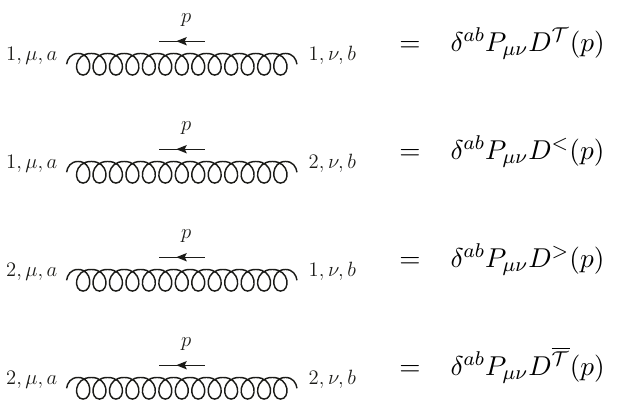
Figure 2. Feynman rules associated with different types of gauge boson